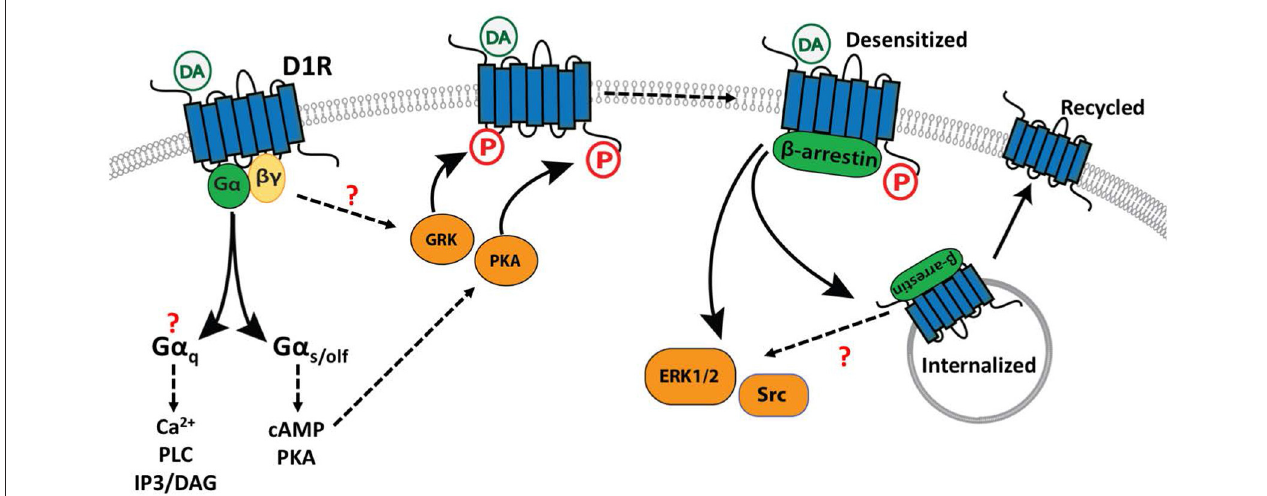
FIGURE 2 | Effector coupling of the D1R. Shown are the main interactions of the D1R with three sets of downstream effectors/modulators. Regulatory interactions that have not been fully elucidated, or for which contradictory evidence exists, are indicated with a “?”. Binding of a ligand such as dopamine (DA) activates G protein-dependent (Left) signaling through multiple effectors. Desensitization of the receptor (Center) is mediated by phosphorylation (P) of the C terminal tail and intracellular loops by GRKs and PKA. β -arrestin binding to the phosphorylated receptor (Right) mediates desensitization, internalization, and potentially additional intracellular signaling events generated through the activation of ERK1/2 and Src protein